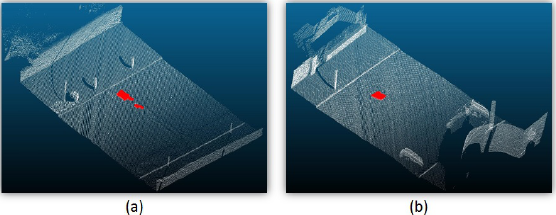
Figure 5: 3D road roughness regions represented in red in the (a) first and (b) second section of urban